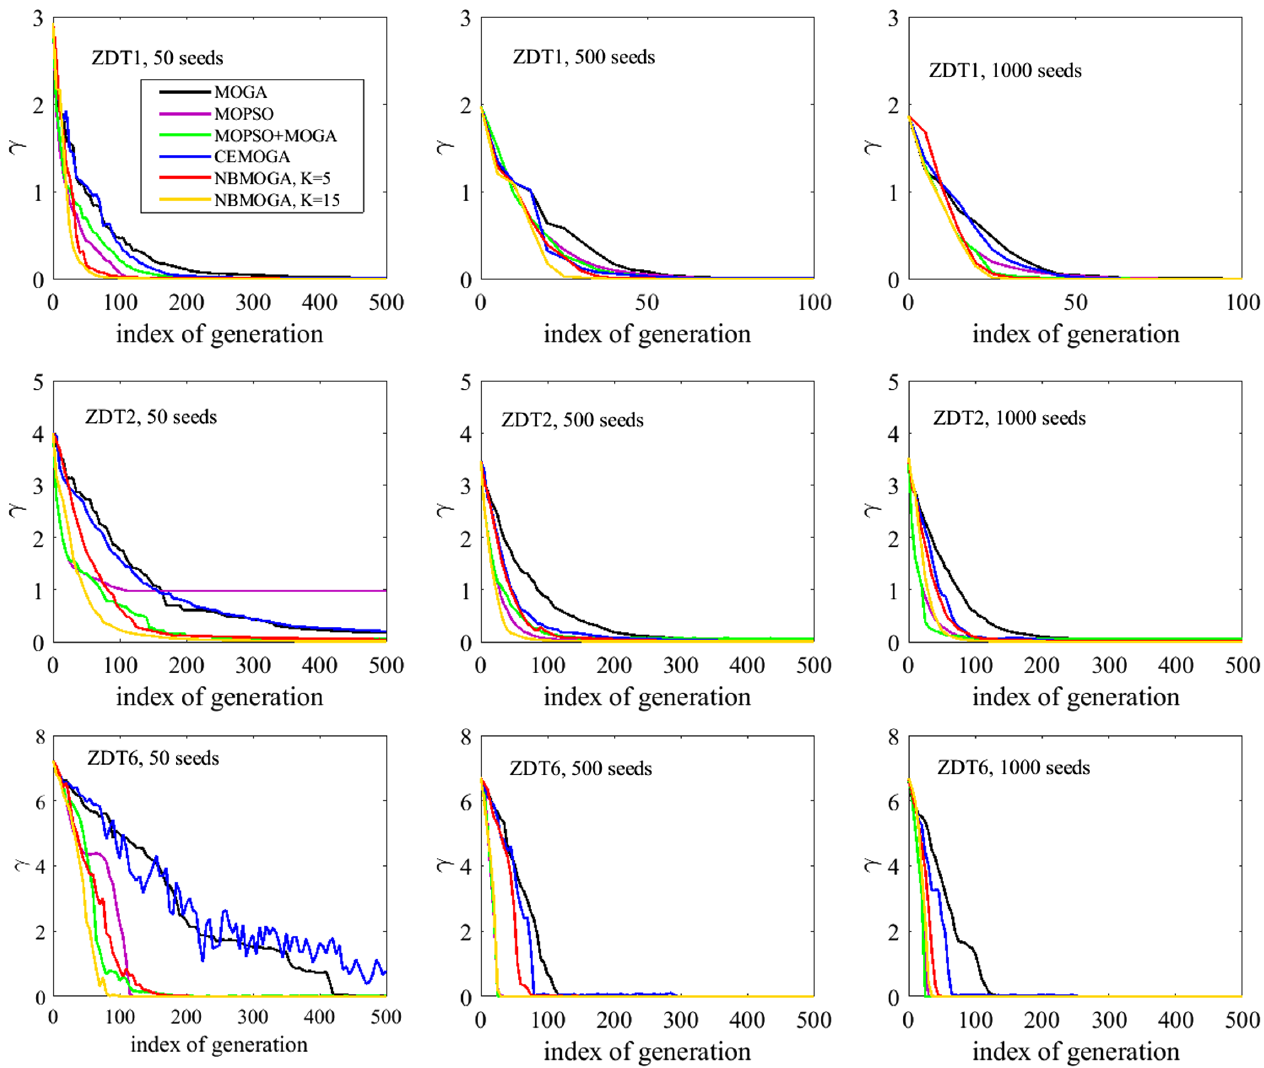
FIG. 3. The evolutions of γ over generations for a few cases. For the combination of MOPSO and MOGA, the data of the first 20 generations are obtained from the MOPSO optimizations — i.e., the purple and green curves are the same in the first 20 generations — and the data of the 21st to the last generations are obtained with the standard MOGA. In the cases of optimizing ZDT1 with population sizes of 500 and 1000, the convergence is fast, and only the first 100 generations are illustrated for a clear